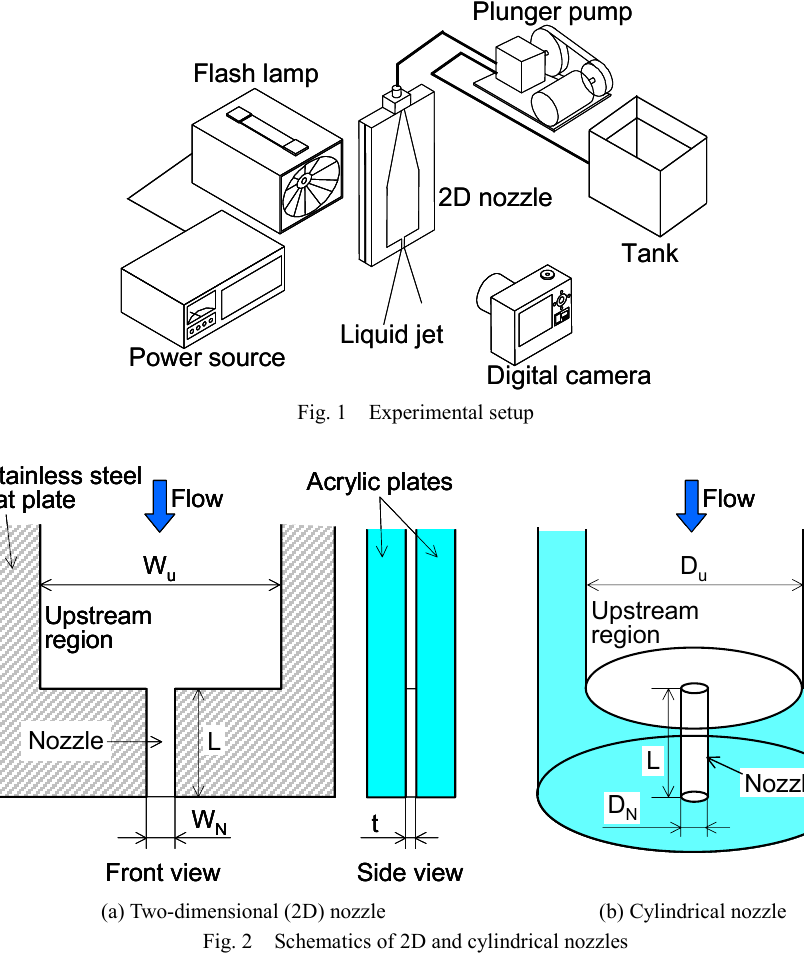
Fig. 2 Schematics of 2D and cylindrical